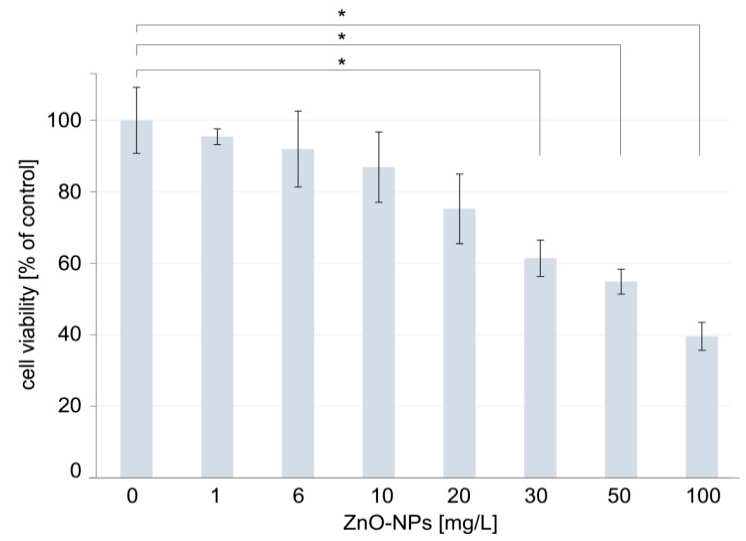
Figure 2. Viability of the human HeLa cells exposed to increasing concentrations of ZnO NPs. Significant differences between groups treated with ZnO NPs and the control group were marked with * (p < 0.01).